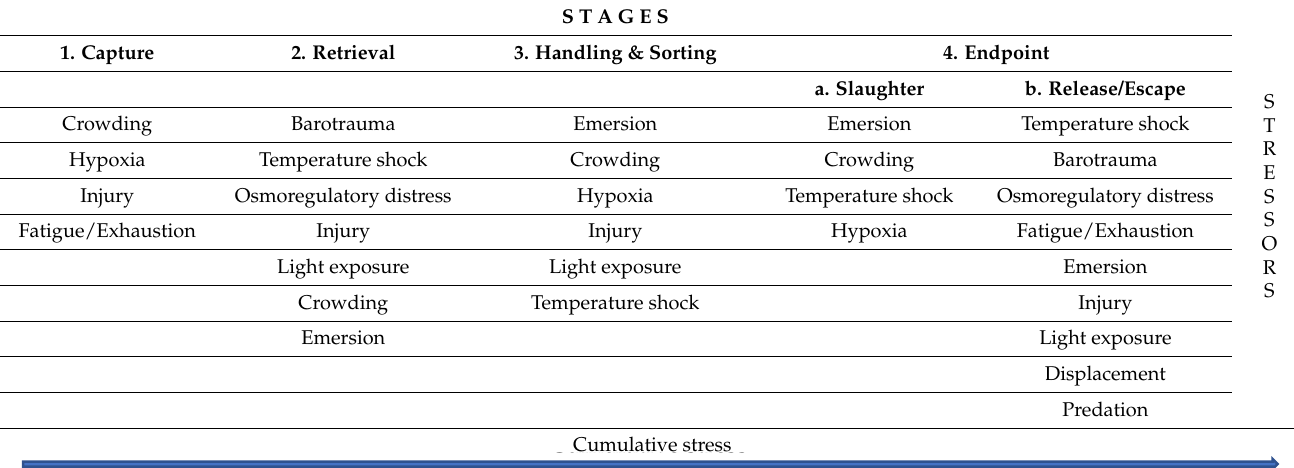
Table 1. Four stages of a catch and the stressors encountered. Adapted from Breen et al., (2020) [8].